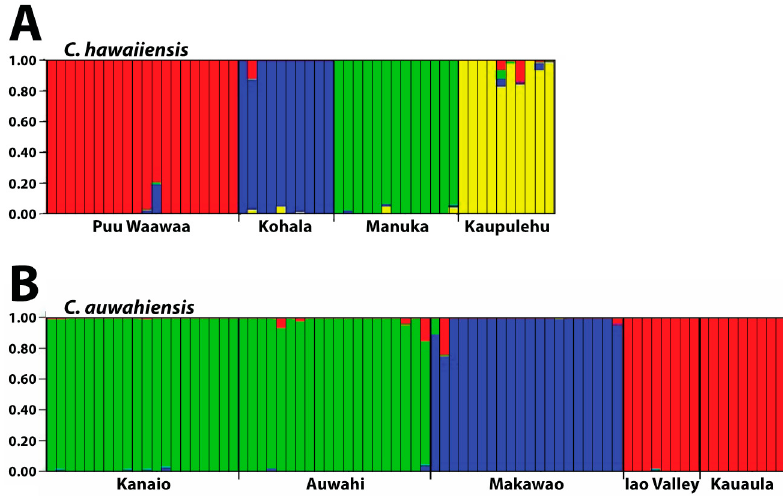
Figure 4. Genetic STRUCTURE bar graph of Chrysodracon species from combined RAPD and ISSR data. Individuals genotyped in this study are represented by a single vertical bar partitioned into colored segments that represent the individual’s probability of belonging to a particular group (K).